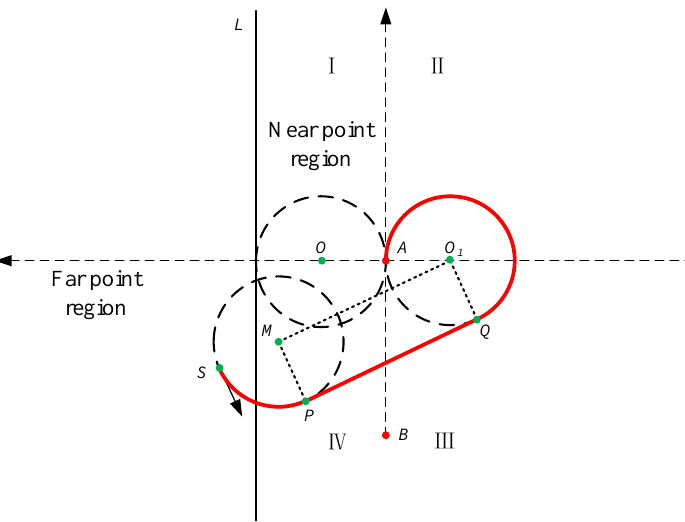
Figure 6. The situation where the far point region is in region IV (route 1 (cid:48)(cid:48)